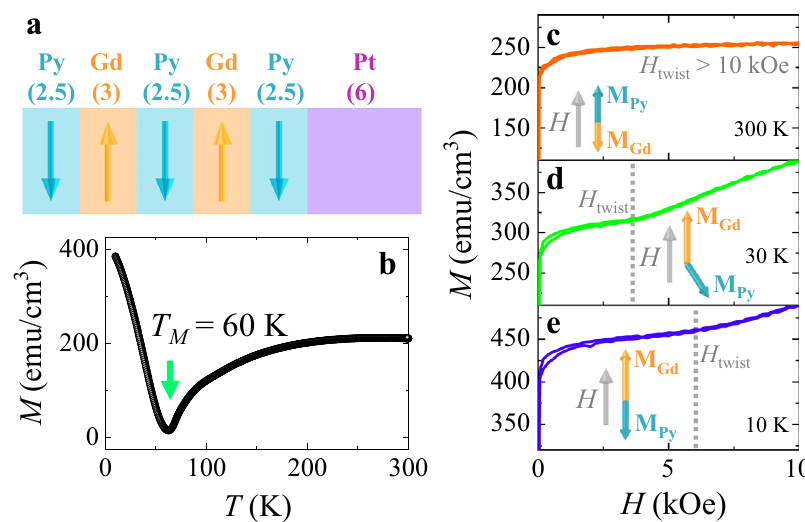
Fig. 2 Static magnetization of Py/Gd multilayer. a Sketch of the Py/Gd/Py/Gd/Py/Pt sample (the numbers in parentheses are thicknesses in units of nanometers). b Temperature dependence of in-plane magnetization at H = 50 Oe; the green arrow indicates the compensation temperature T M . The positive half branches of the hysteresis loops at ( c ) T = 300 K, ( d ) T = 30 K and ( e ) T = 10 K. The twisted state is achieved at H > H twist (gray dotted lines in d , e ), while the Gd-aligned phase is retained at H < H twist at T = 30 K and 10 K. At T = 300 K, only the Py-aligned phase is achievable within the H range in our experiments. The Py-aligned phase, twisted state and Gd-aligned phase are illustrated in c – e . The perfect antiparallel alignment of M Py and M Gd is ensured in the Py-aligned phase and Gd-aligned